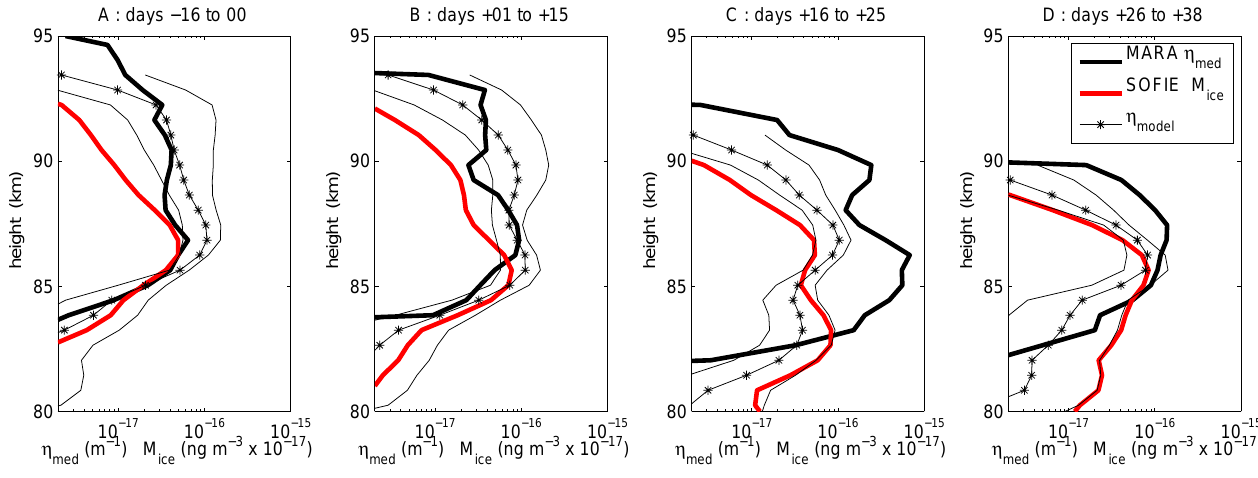
Fig. 5. Average profiles of ice mass density measured by SOFIE, PMSE volume reflectivity measured by MARA and volume reflectivity predicted by an empirical model, for four different parts of the season. Model profiles are represented as the most likely value (thin black line with *) and by the upper and lower limits for the 67% confidence levels (thin black lines without markers). See text for further